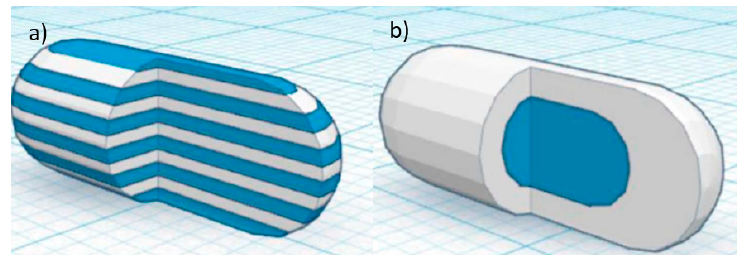
Figure 10. A 3D computer-aided design (CAD) model of capsule-shaped oral drug delivery device ( a ) multilayer device ( b ) two-compartment caplet (Duocaplet) (Reproduced with permission from reference [83], American Chemical Society (ACS), 2015).